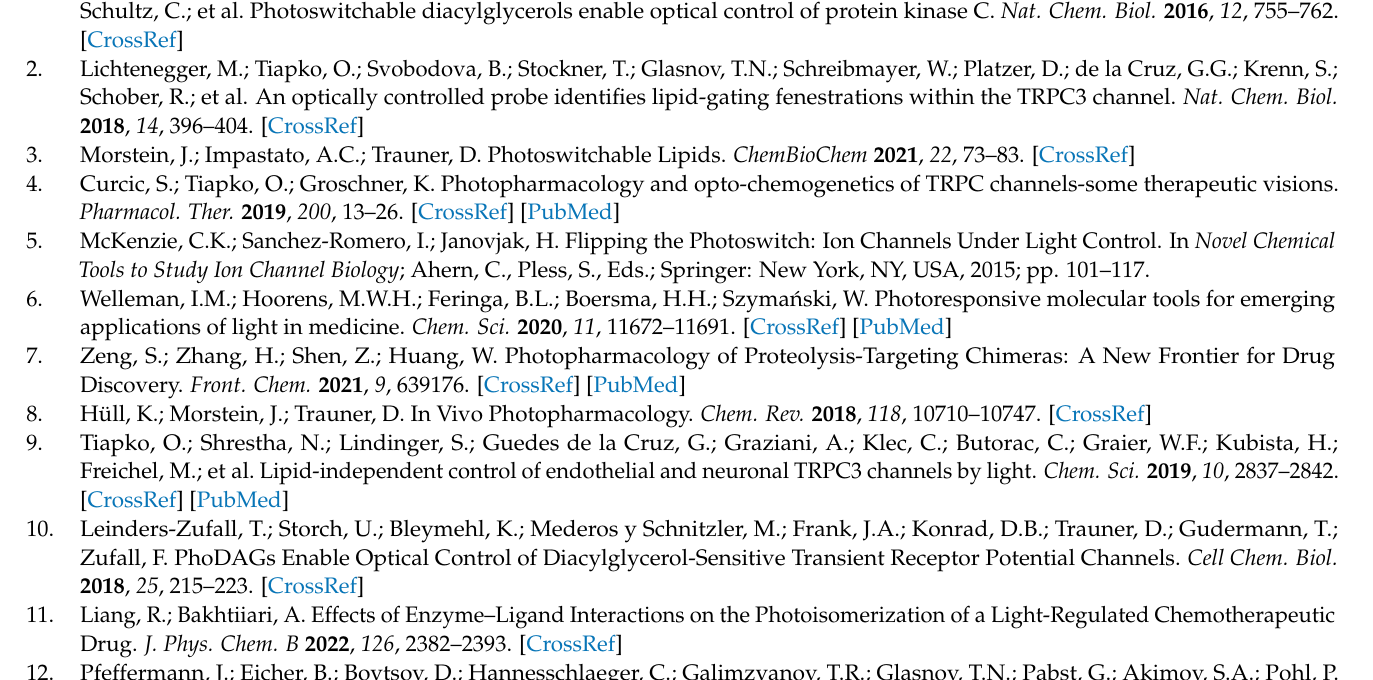
Figure S2: Control experiment showing electrodeformation of pure POPC GUVs in the presence and absence of UV/blue light, Figure S3: L2-binding site structure of TRPC3, Figure S4: Mutations in the L1 region do not alter thermal relaxation of OptoDArG-mediated deactivation kinetics in the